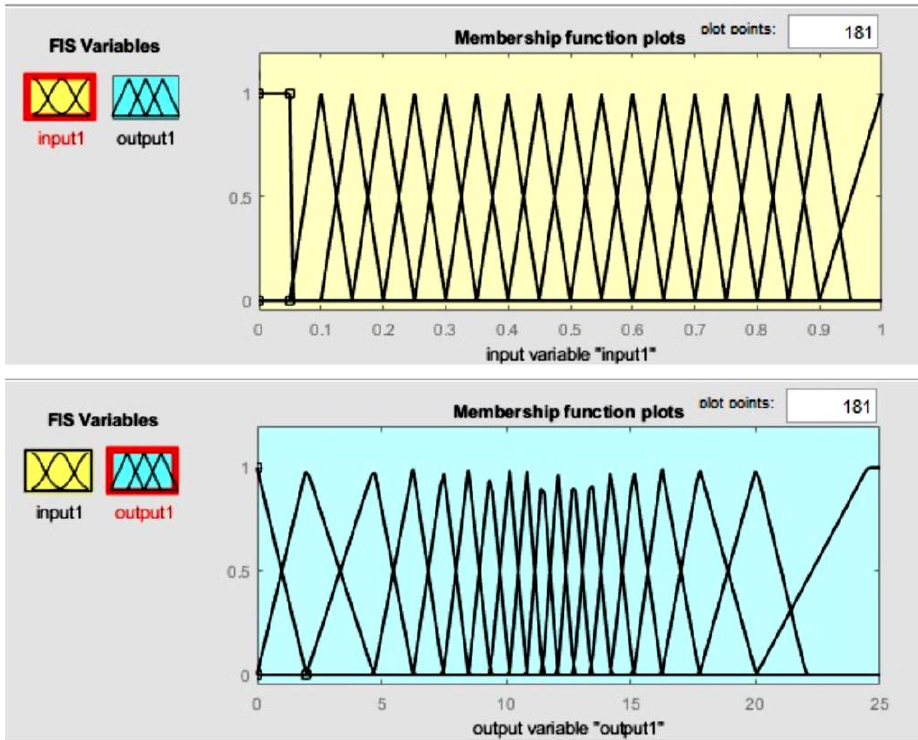
Figure 10. MFs for throttle input and MAP output.